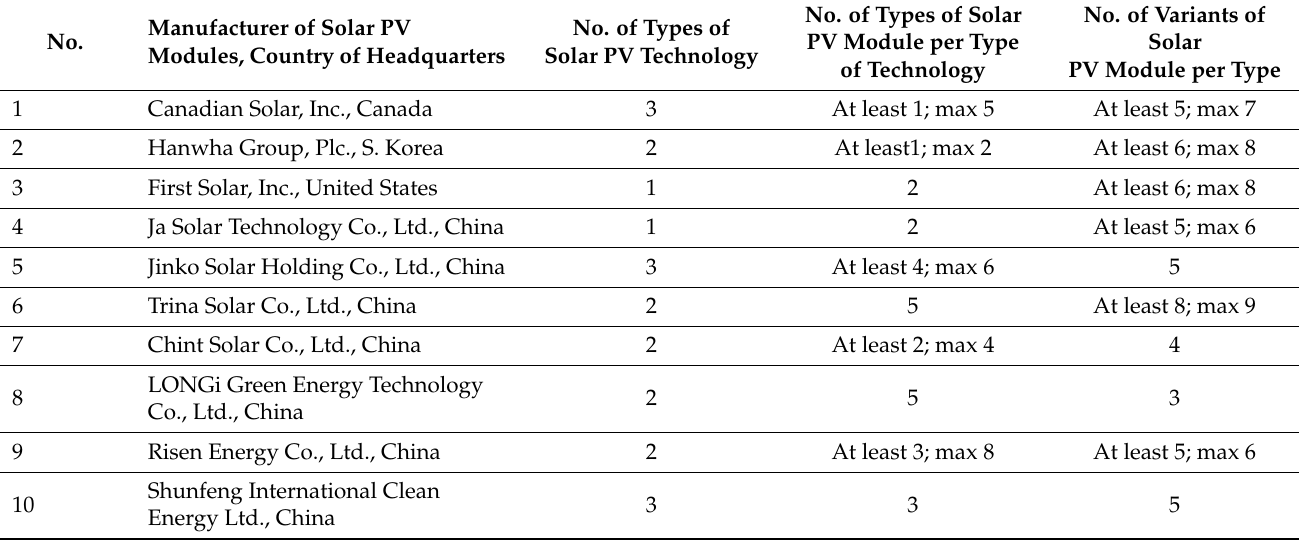
Table 1. The 10 leading manufacturers (in actual shipments in 2019–2021)